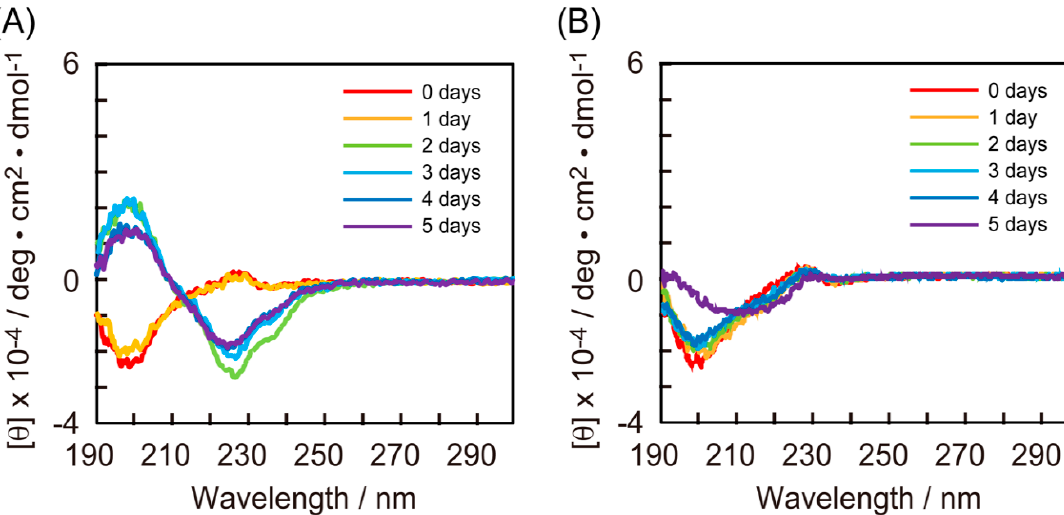
Figure 2. Typical circular dichroism (CD) spectra of RU003 in the ( A ) absence and ( B ) presence of Ape5-TD (conditions: [RU003] = 100 µM and [Ape5-TD] = 10 µM in water at 40 °C). The y -axis indicates the mean residue ellipticity. Incubation period “0 day” means “5 min after the reaction started”.